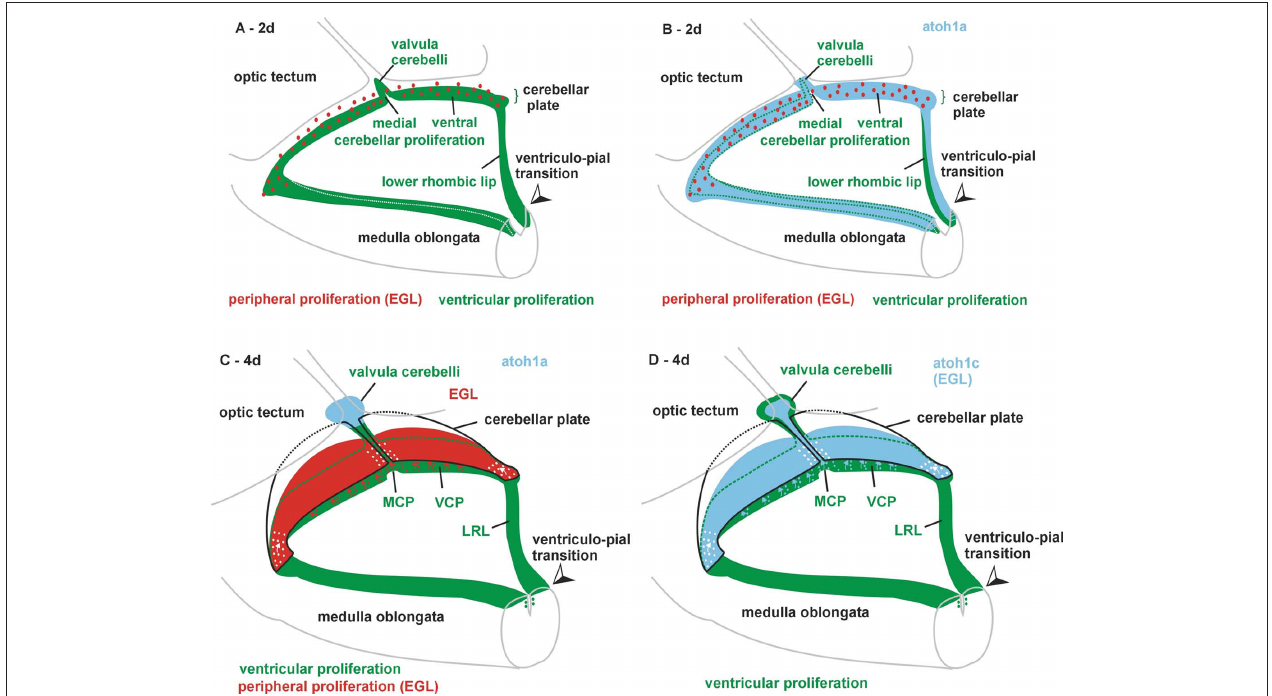
medial (MCP) and ventral cerebellar proliferation (VCP) and later in valvula cerebelli are shown in green, peripheral proliferation in EGL in red. Note that expression of atoh1a is now restricted to the valvula. Also, the ventriculo-pial boundary is in an everted position as shown in Figures 4 F,g . (D) Same schema with expression of atoh1c added in light blue. Note that in both (C,D) the exact position of little arrows indicating dorsal cell migrations for the formation of the EGL (but not its existence) is hypothetical. Synthesis of our data and those of Kani et